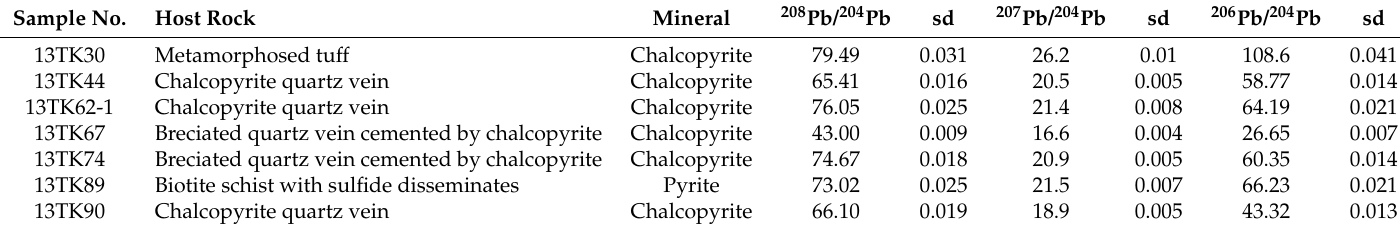
Table 2. Pb isotopic composition of sulfides of the Tongkuangyu Cu deposit, North China Craton. Sample